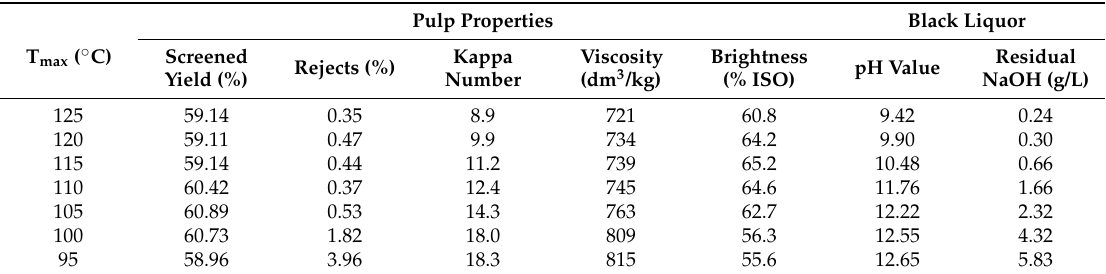
Table 2. Effects of maximum pulping temperature on soda-oxygen pulping of the bagasse.